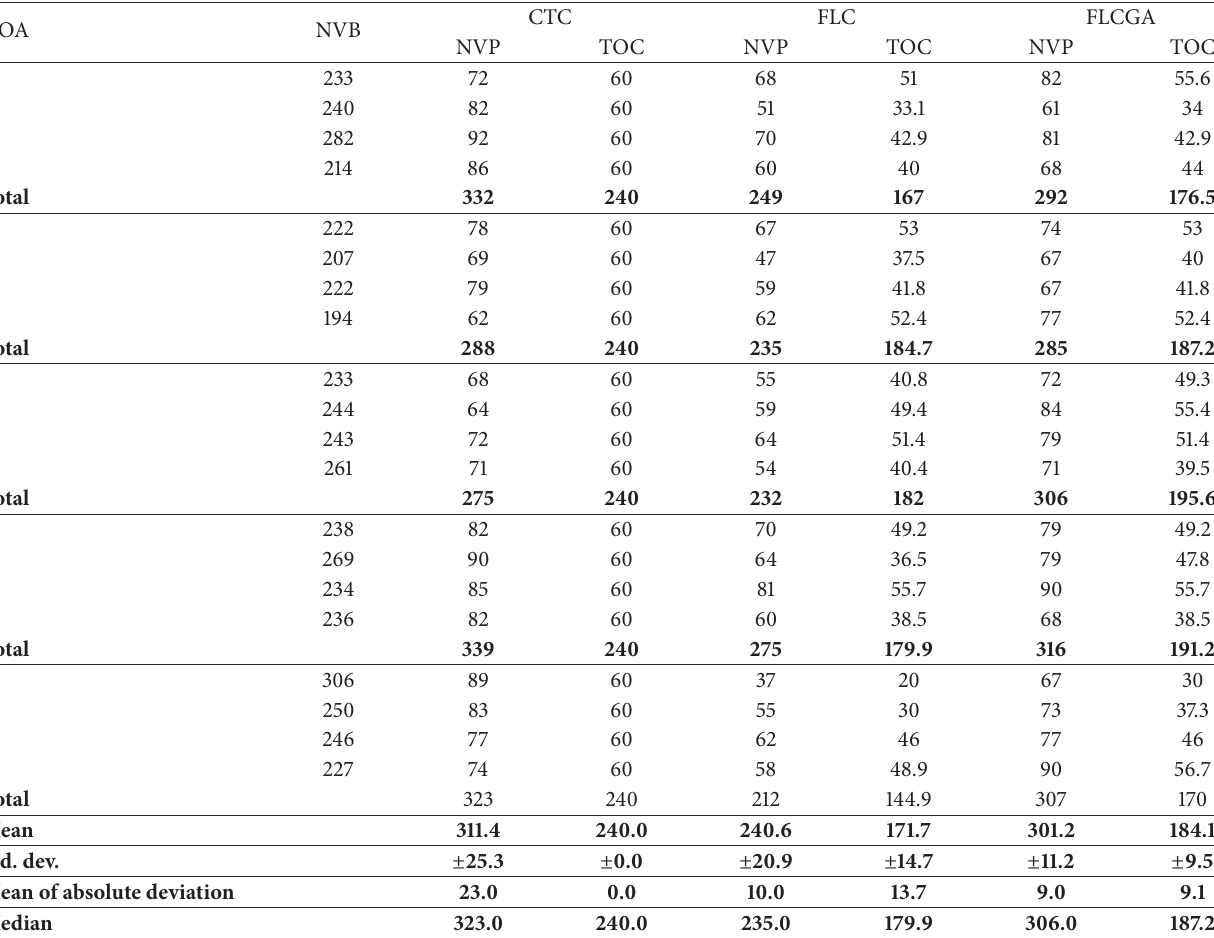
Table 3: Results of one cycle of the traffic signal that contains four passing signals, Conventional Traffic Controller, CTC, FLC with traditional logic method, and FLC with Genetic Algorithms, FLCGA. NVB is the number of vehicles that exists in the area of the four intersections before applying the method; NVP is the number of vehicles passing the traffic signal. TOC is the summation of the total time of green lights time interval in the four intersections at the same time decided by the